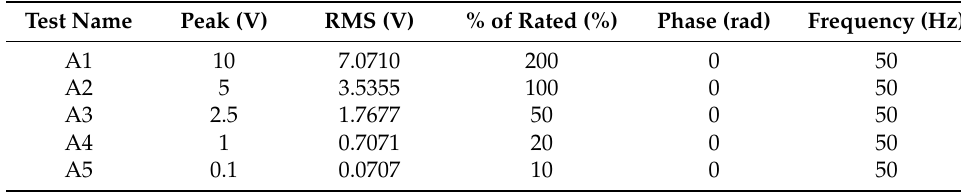
Table 11. Settings of the amplitude tests.